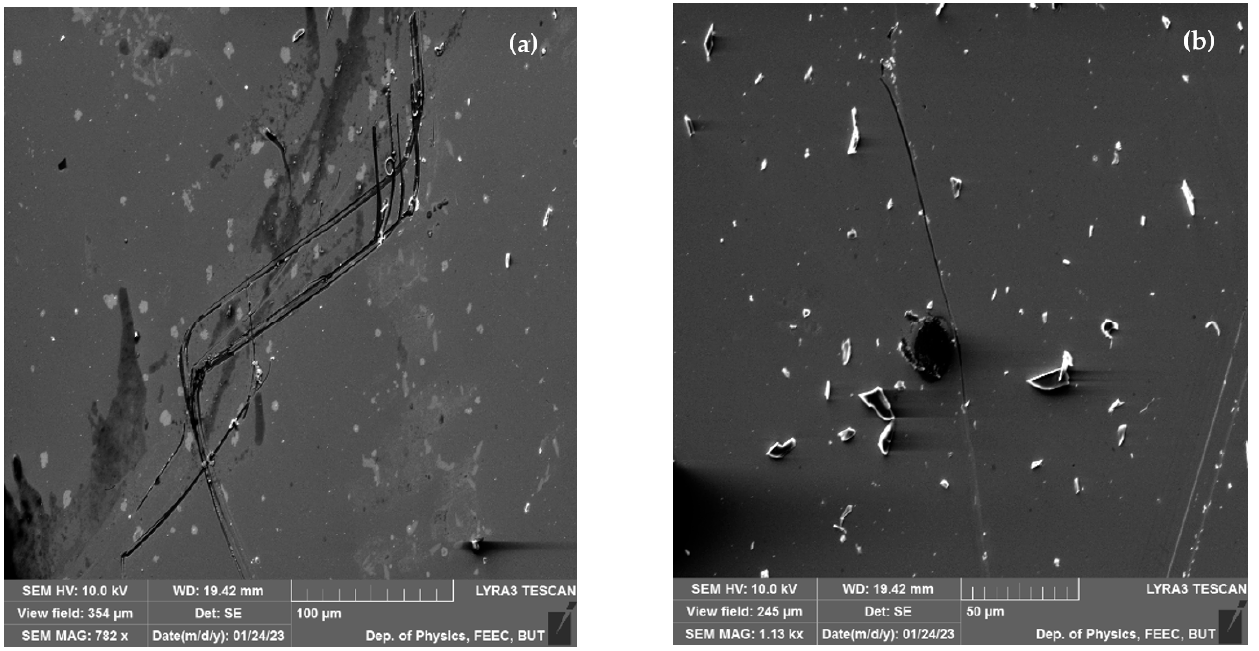
Figure 3. Mechanical scratches on surface of produced samples ( a , b ) di ff erent scanning areas.